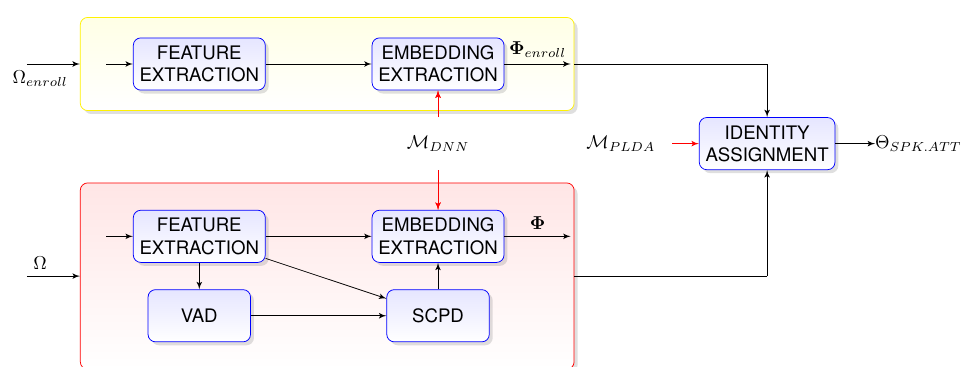
Figure 4. Flowchart of the direct assignment approach. Red and yellow boxes, respectively, represent the embedding extraction pipelines for the evaluation audio Ω (online) and enrollment audios Ω Φ and Φ enroll (offline). The obtained embeddings ( enroll ) are taken into account in the identity assignment block.